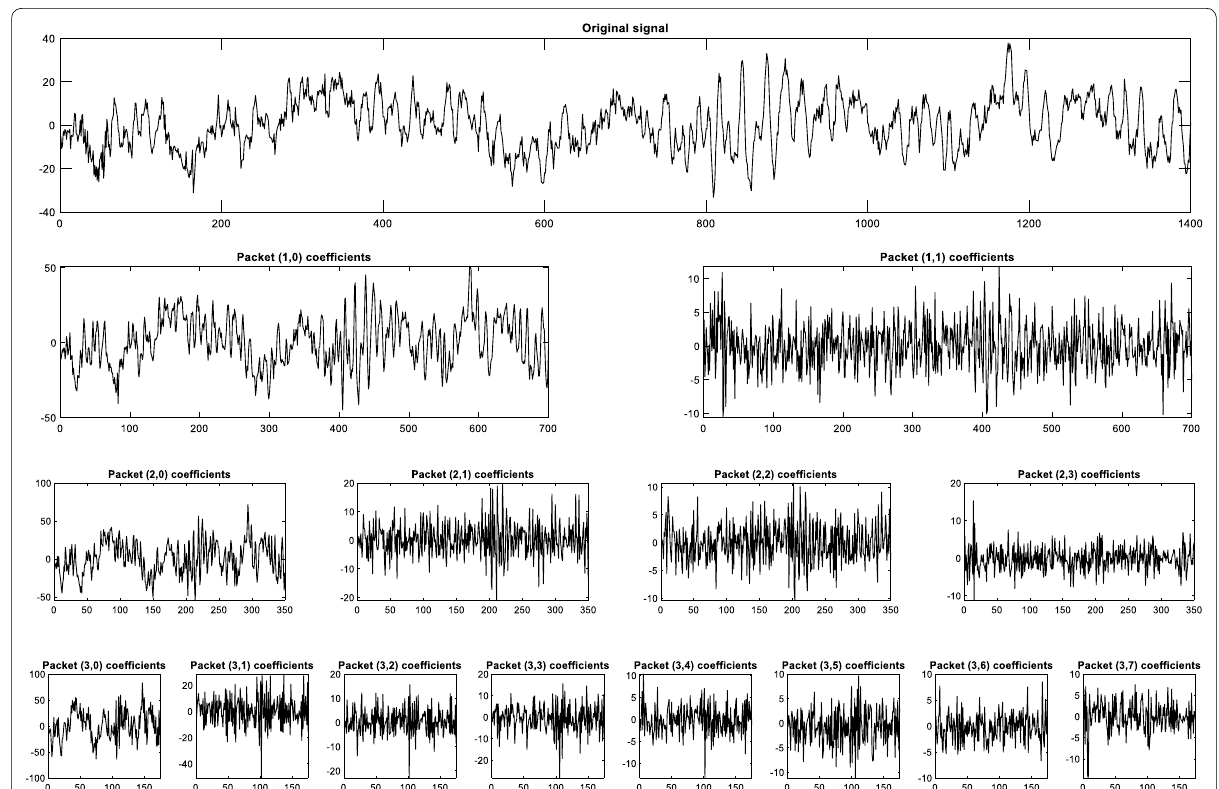
Fig. 5 An example of the wavelet packet decomposition (up to level 3) on a randomly selected EEG signal of the utilized